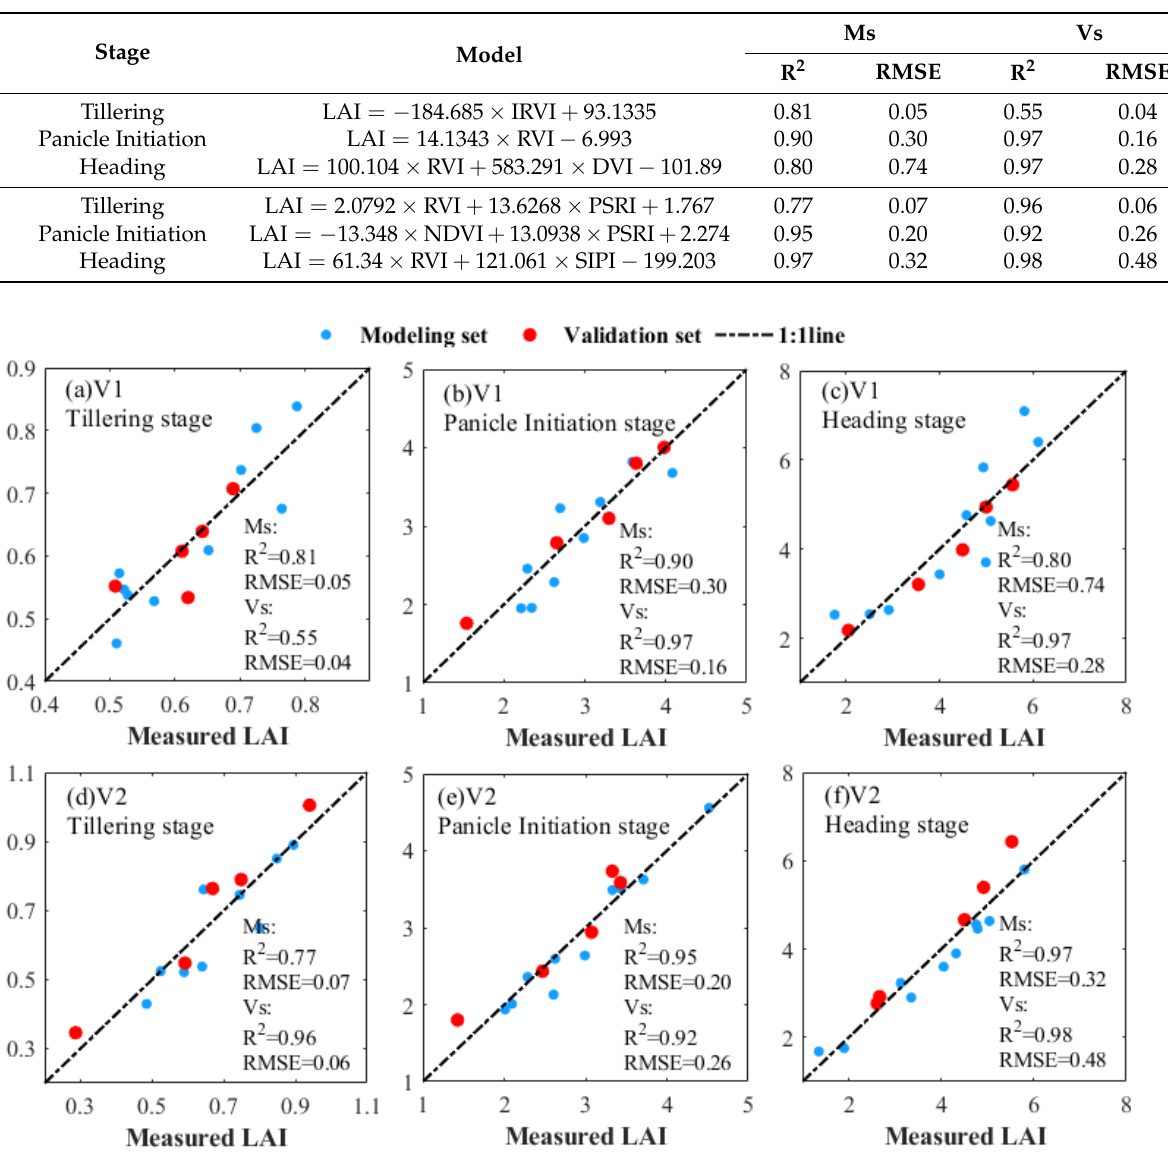
Figure 5. Scatterplots of measured and predicted leaf area index (LAI) values for rice varieties: V1 (Meixiangzhan 2) at ( a ) the tillering stage, ( b ) panicle initiation stage, and ( c ) heading stage; and V2 (Wufengyou 615) at ( d ) the tillering stage, ( e ) panicle initiation stage, and ( f ) heading stage.